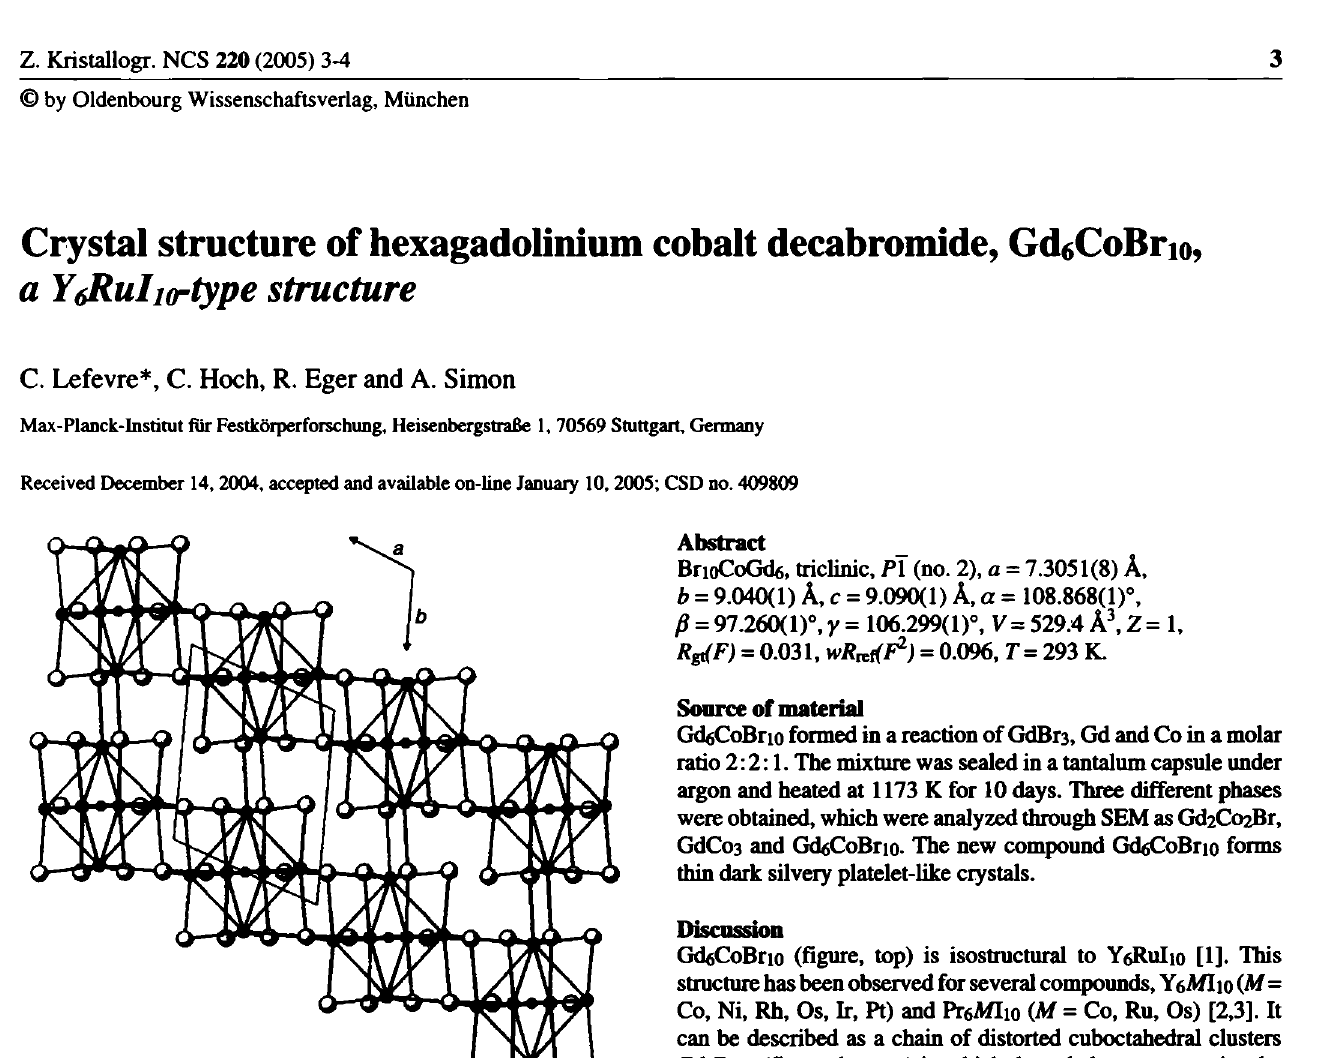
Table 1. Data collection and handling. Crystal: